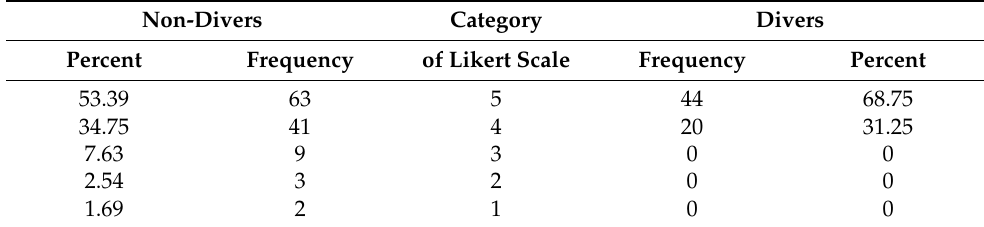
Table 4. Scuba diving impact on a belief in one’s own abilities.